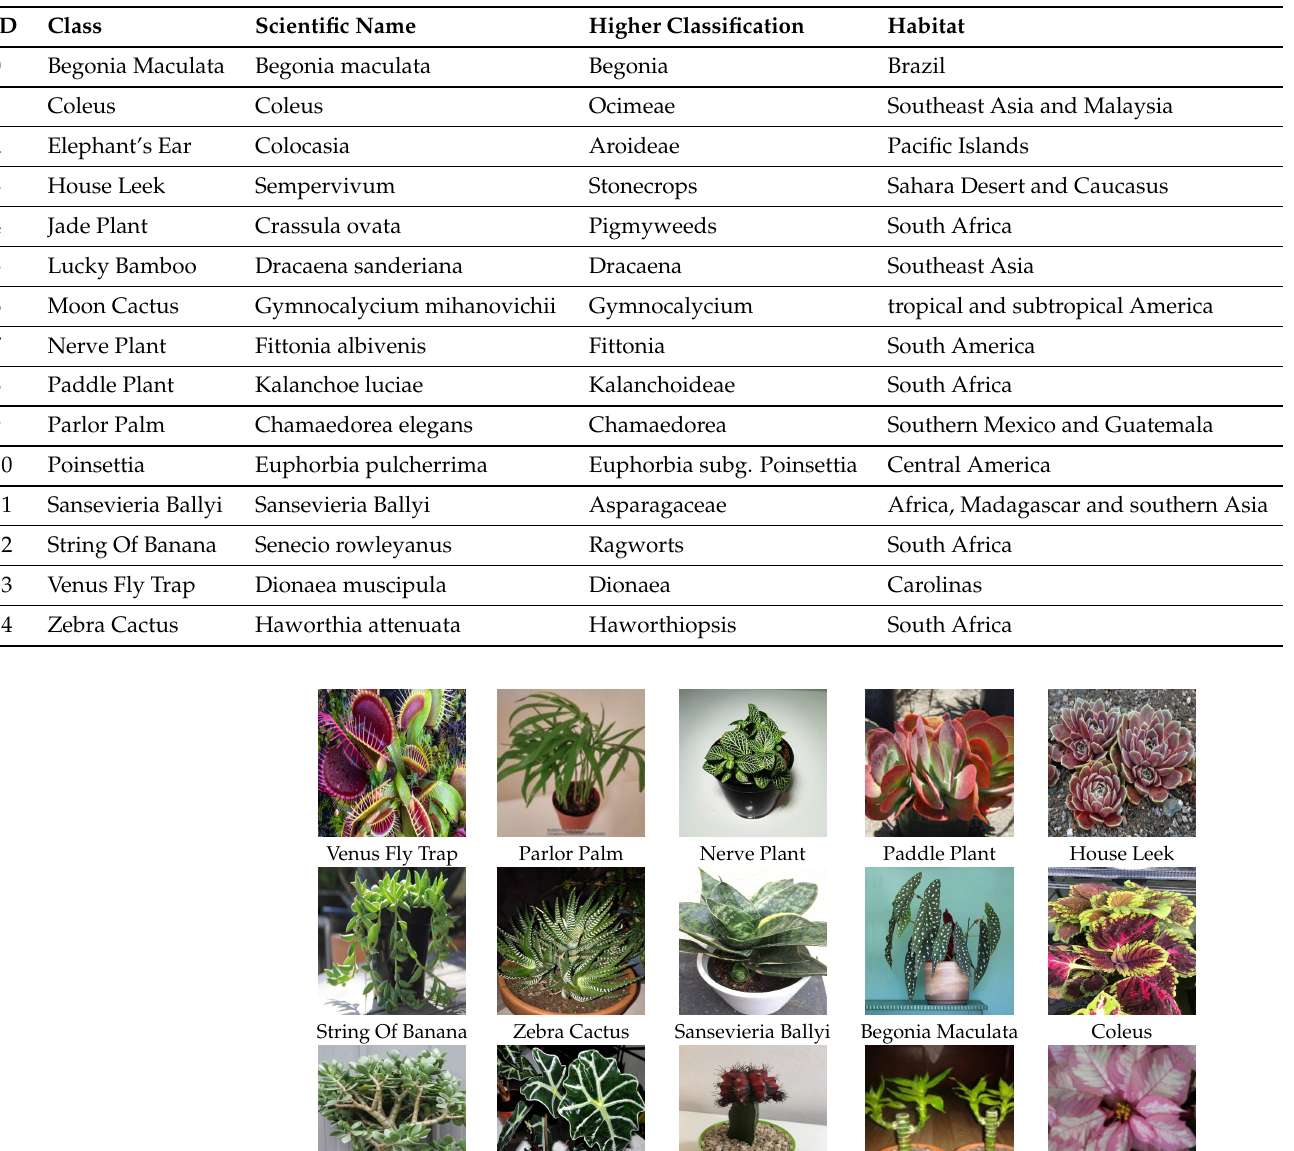
Table 1. The Urban Planter Dataset summary.